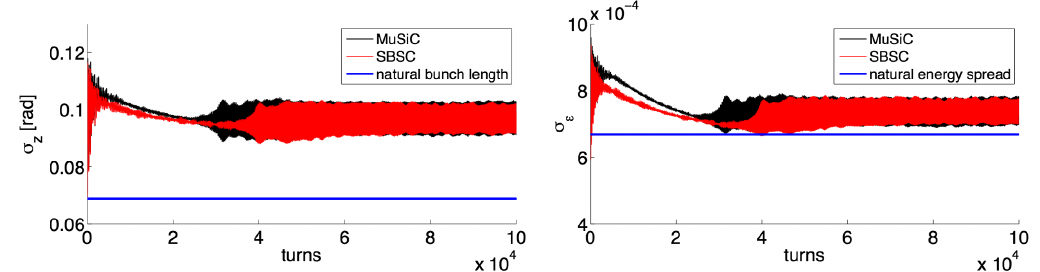
FIG. 11. Comparison of the rms bunch length (left) and energy spread (right) as a function of number of turns in the microwave instability regime between M U S I C and the single bunch simulation code